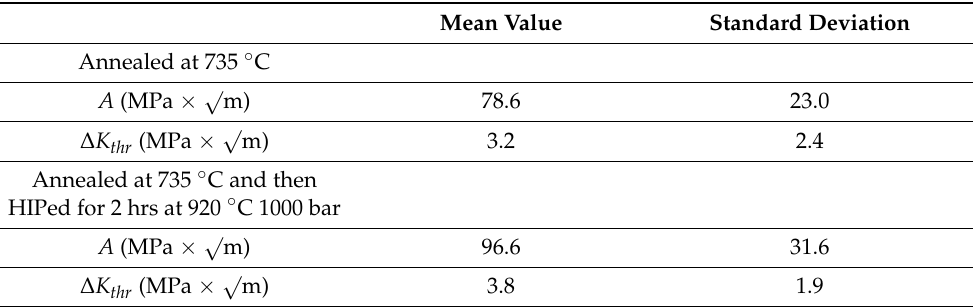
Table 3. Mean and standard deviations of ∆ K thr and A associated with SLM Ti-6Al-4V specimens with and without